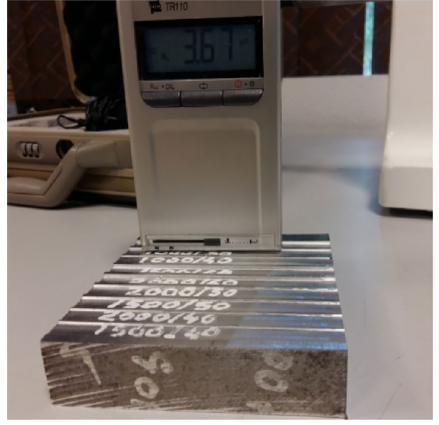
Fig. 3 Portable surface roughness tester-TR110